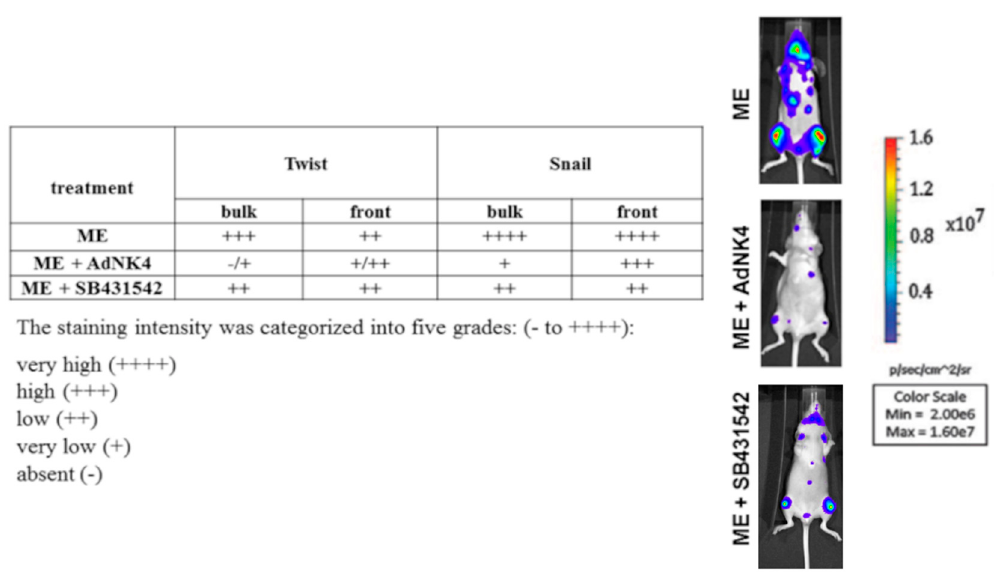
Figure 2. Semiquantitative evaluation of Twist and Snail expression. The expression of Twist and Snail was evaluated by immunohistochemistry on bone slides from 3 mice per group, i.e., ME at 25 days, and ME treated with AdNK4 or SB431542 at 32 days; the degree of positivity of the signals was shown as staining intensity. We report the bioluminescence images of representative mice from each of the three groups of treatments.